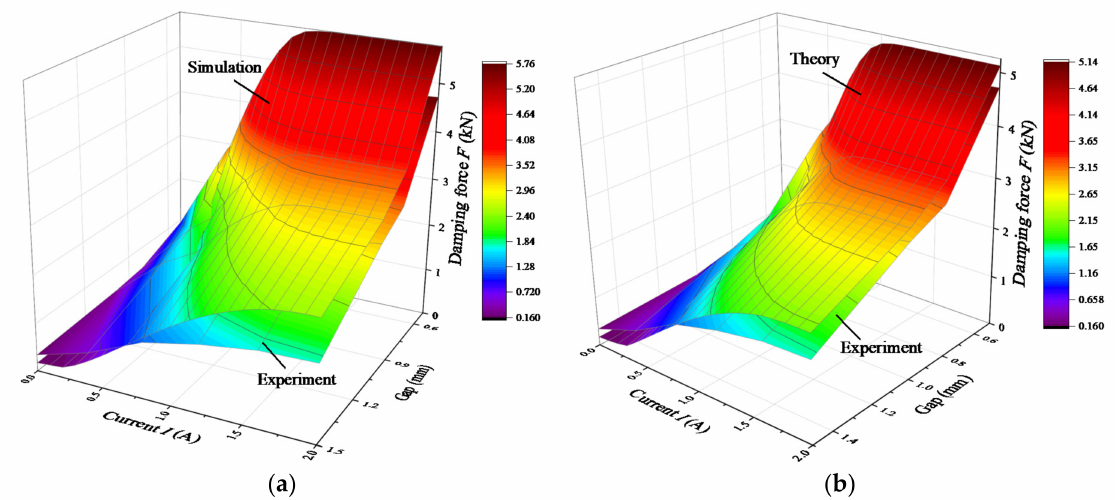
Figure 23. Dynamic variation of experiment, simulation, and theory damping forces under different currents and variable radial gaps: ( a ) simulation versus experiment, ( b ) theory versus